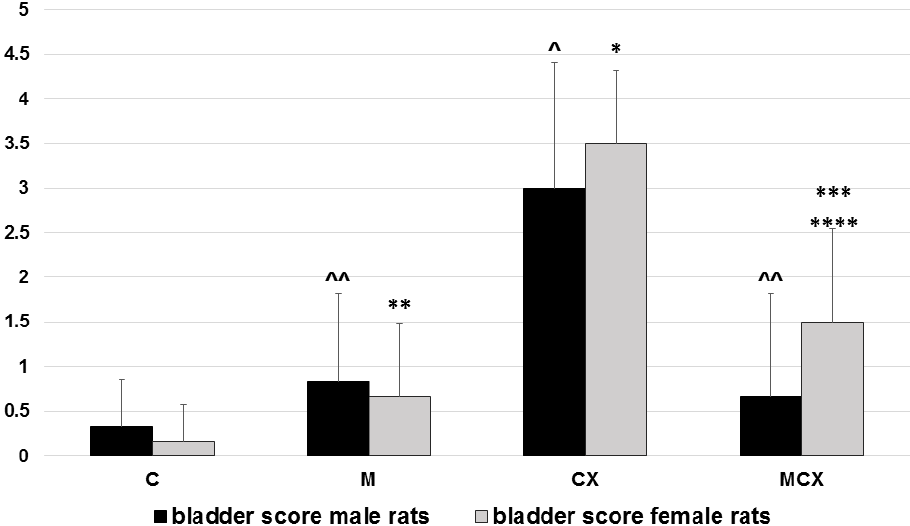
Figure 2. Total urinary bladder score (hemorrhage, edema, erosions, 0–6 points) in male and female rats. Scoring system described in the Material and Methods section. Male rats: ˆ p < 0.001, CX vs. C; ˆˆ p < 0.01, M vs. CX and MCX vs. CX. female rats: * p < 0.001, CX vs. C; ** p < 0.001, M vs.CX; *** p < 0.01, MCX vs. CX; **** p < 0.05, MCX vs. C. Data presented as mean values.